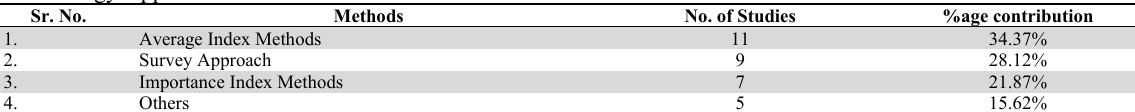
Methodology Applied Sr. No.